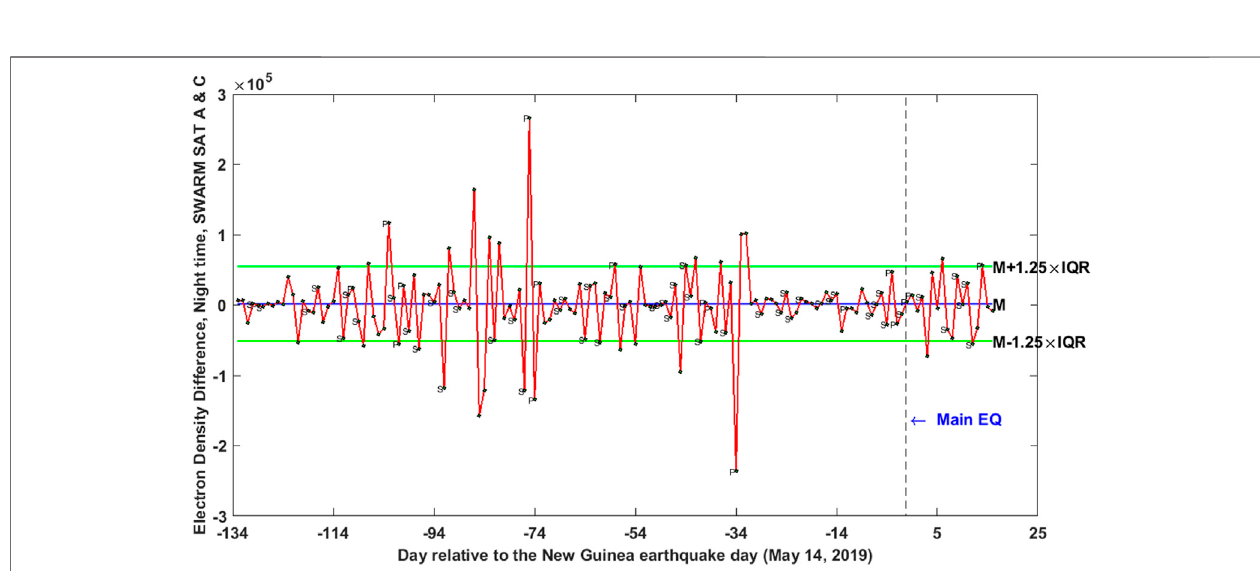
FIGURE 10| Differences between gradients ofelectron density values measured by Swarm A and C from January 01 to June 30, 2019 at night time. The symbols “ P ” and “ S ” indicate disturbed magnetic days ( “ P ” according to magnetic indices, “ S ” according to solar parameters).